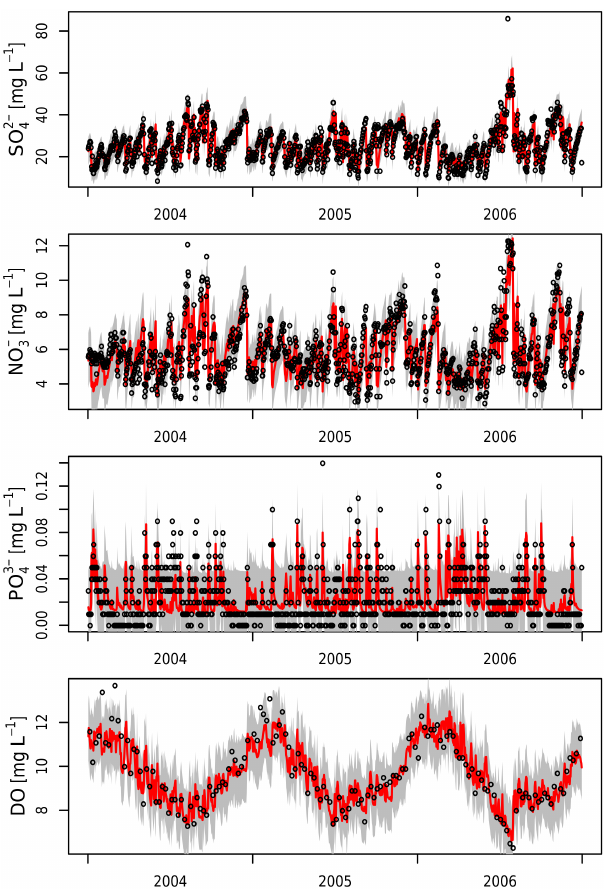
Figure 2. Calibration performance for selected inorganic parame- ters. Dots are observations, the red line is the model simulation with maximum posterior probability parameters, and the grey region is the 95% uncertainty interval (total uncertainty). All values are daily mean